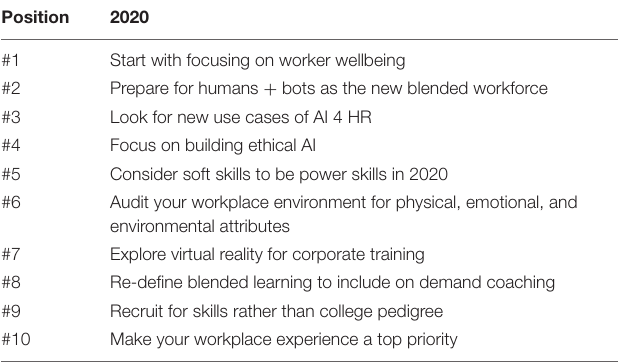
TABLE 1 | Top HR talent attraction and retention trends